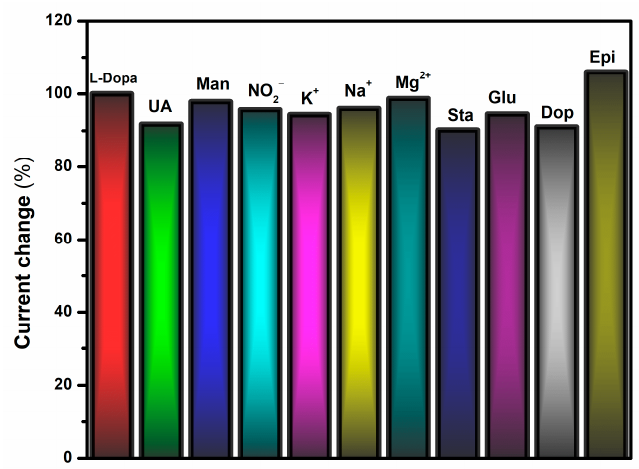
Figure 7. Interferences